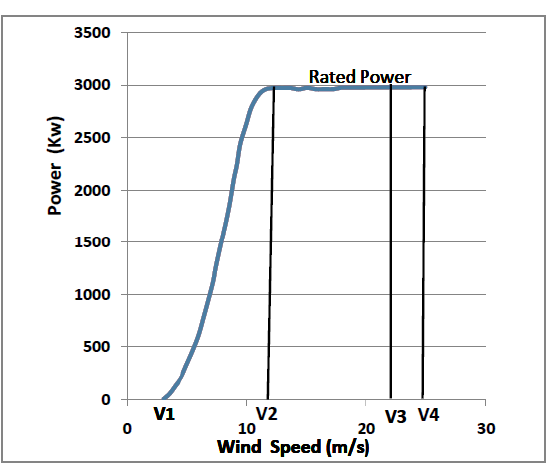
Figure 1. Wind turbine power